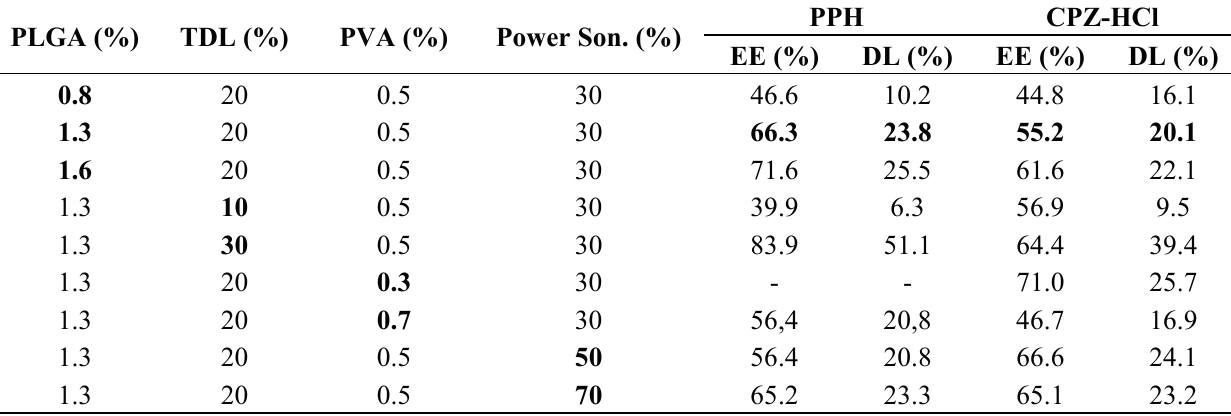
Table 3. Effect of poly( DL -lactide-co-glycolide) (PLGA), the theoretical drug loading (TDL), poly(vinyl alcohol) (PVA) and power of sonication (Power Son.) on encapsulation efficiency (EE) and drug loading (DL). (Numbers in bolt are discussed